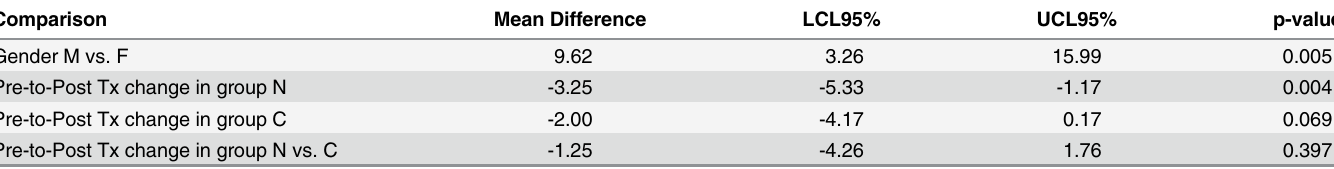
Table 5. Significant predictors of UPDRS Total